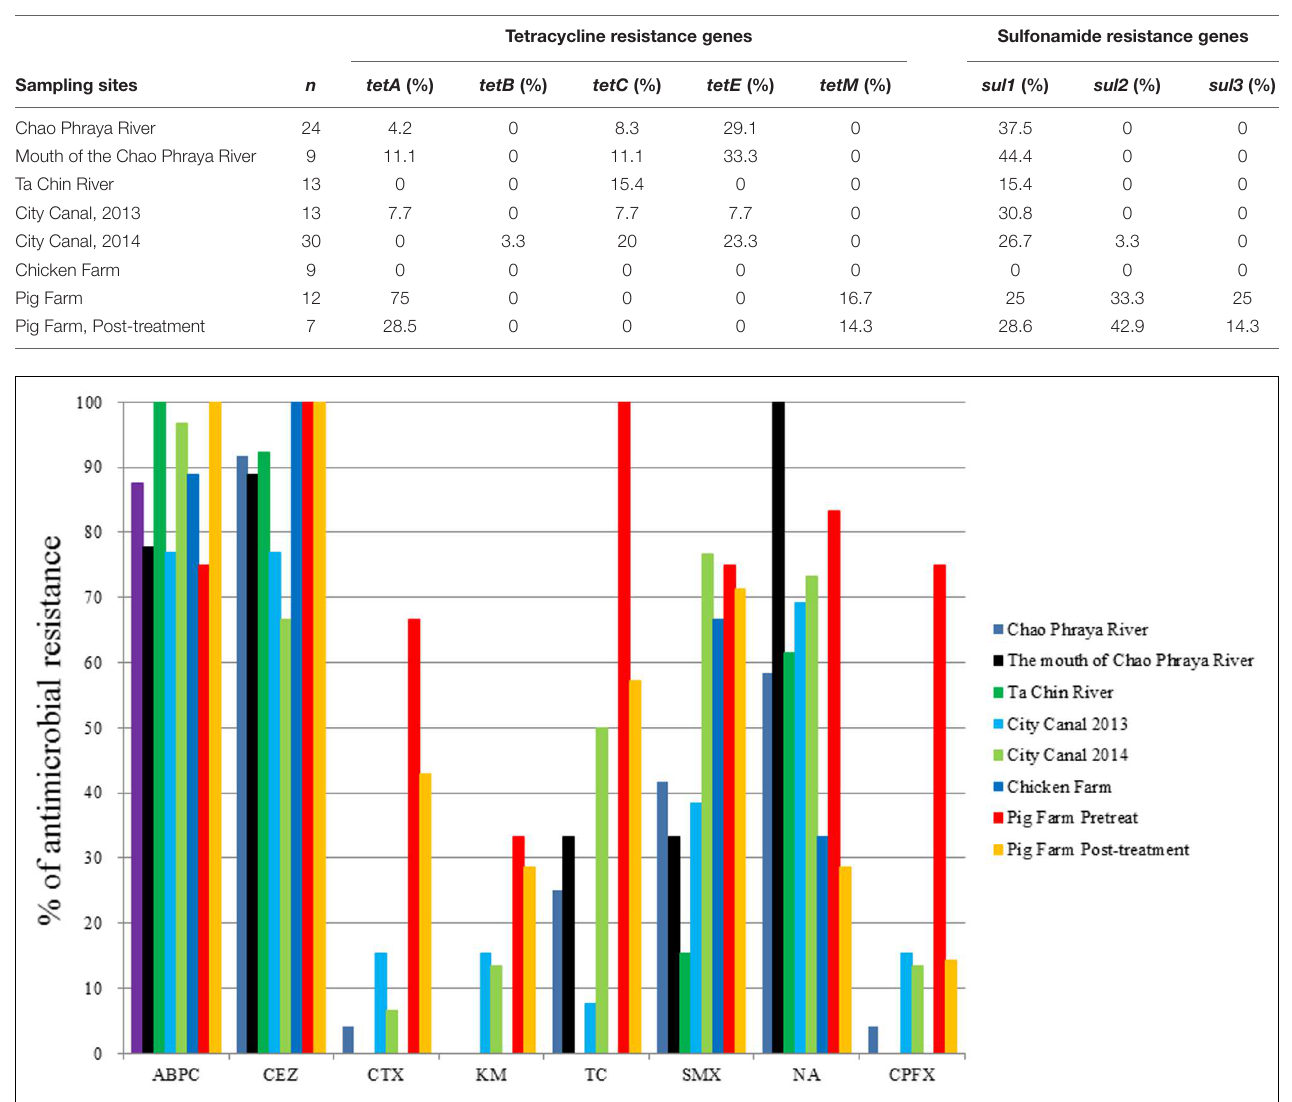
TABLE 1 | Prevalence of antimicrobial resistance genes (ARGs) among Aeromonas spp. isolated from aquatic environments in Thailand. Tetracycline resistance genes